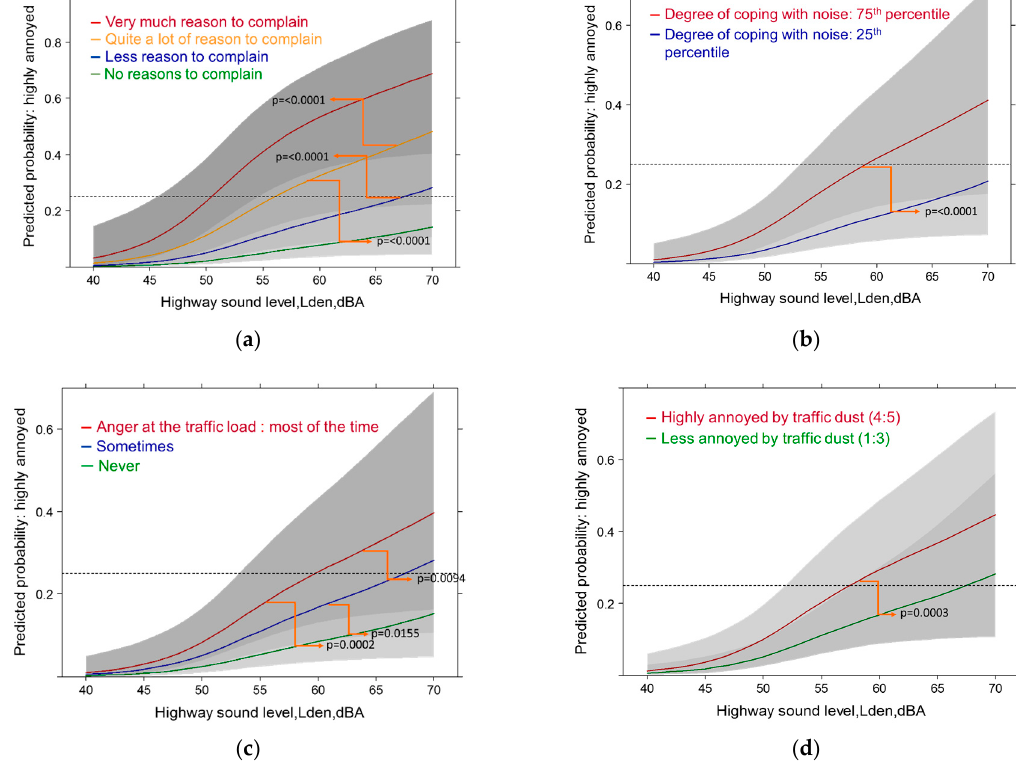
Figure 12. Predicted probability of high annoyance associated with highway sound exposure by: ( a ) complaints about community soundscape; ( b ) coping efforts. Models are adjusted for age, gender, education, health status, sleep score, distance to sources, sensitivity to noise/air pollution, living duration, anger at traffic load, coping (not b ) perceived vibration from road, general satisfaction with life, region and air pollution (annual NO 2 values); ( c ) anger about the traffic load; ( d ) perceived annoyance by dust/soot. Models are adjusted for age, gender, education, health status, sleep score, distance to all sources, sensitivity to noise and air pollution, living duration, complaints about community soundscape, coping, perceived vibration from road, general satisfaction with life, region and annual NO 2 values.